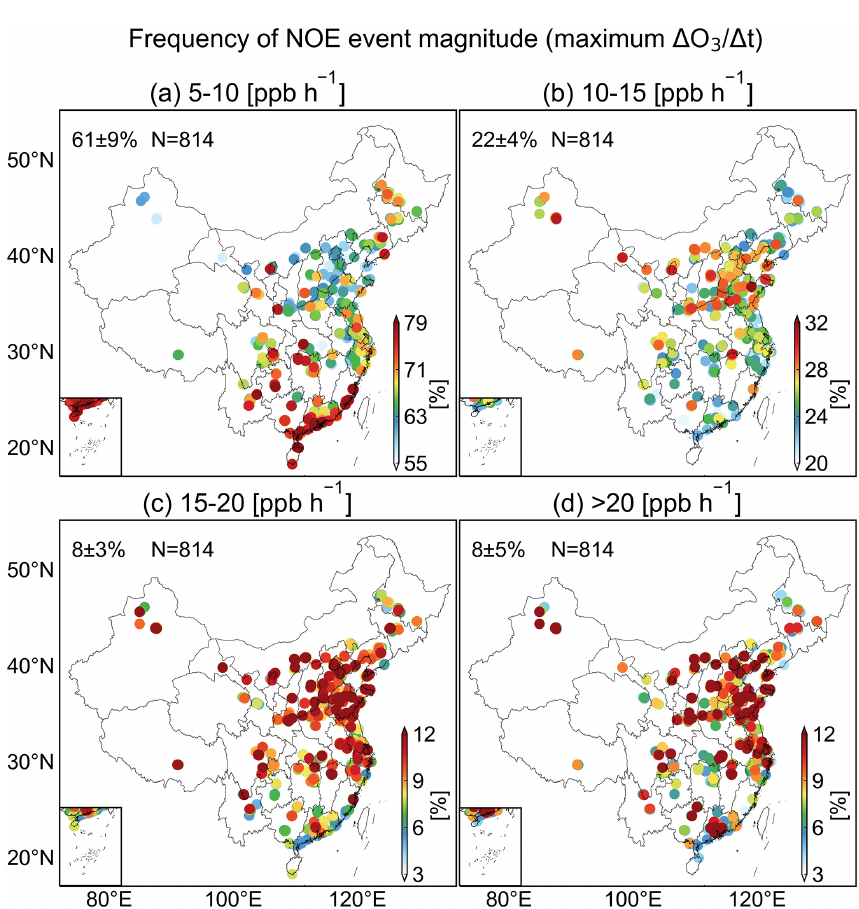
Figure 3. The frequency of different magnitudes of NOE events (the maximum of (cid:49) O 3 /(cid:49)t in an NOE event) in the warm season in China. The regional mean values and standard deviations among the N sites are shown inset at the top of each figure (mean ± standard